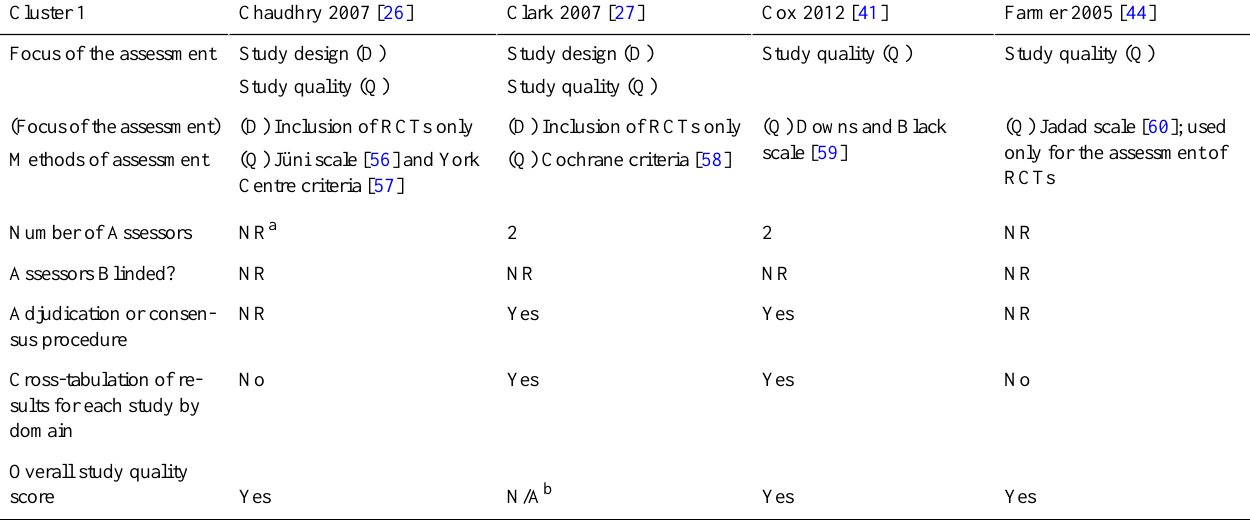
Table 3. Methods and instruments used for the quality assessment of the primary studies—Cluster